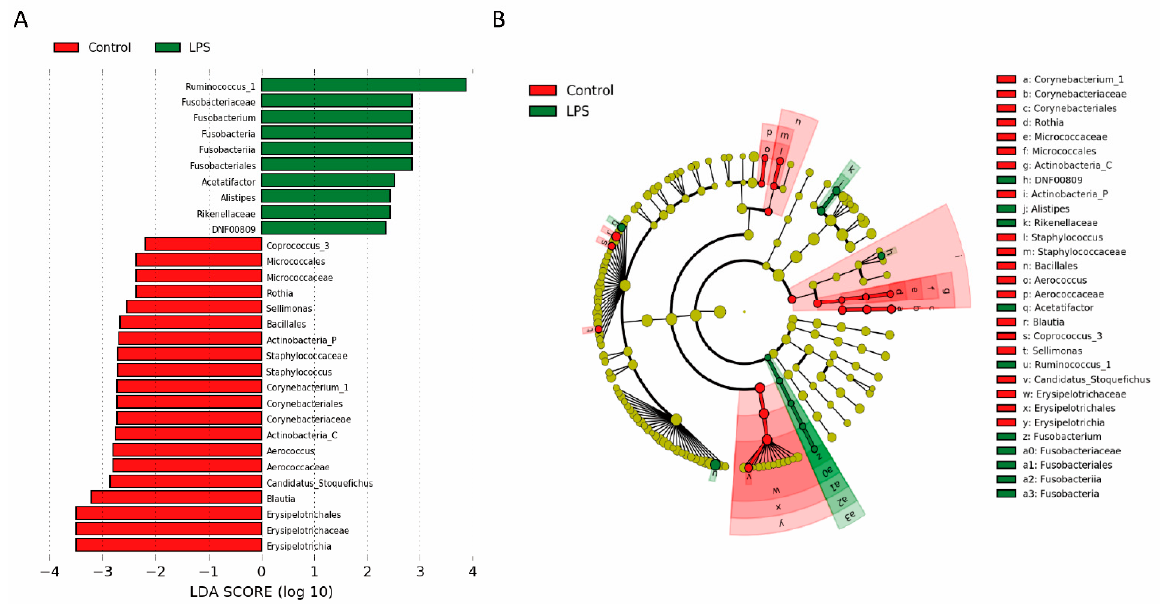
Figure 3. Fecal microbiota was changed in male MIA offspring. ( A ) Linear discriminant analysis (LDA) effect size analysis of gut microbiota changed in MIA offspring (lipopolysaccharide (LPS)) and control rats. Significant biomarkers were defined as taxa with an LDA score (log10) of ≥ 2. ( B ) Significant taxa differences in MIA offspring (LPS) are highlighted on the cladogram.